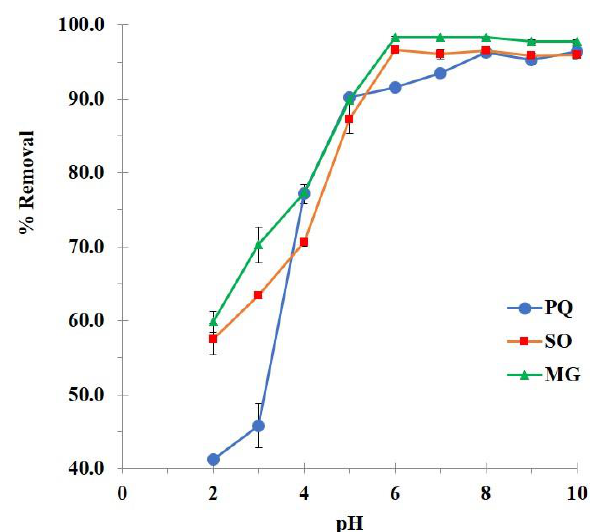
Figure 7. Influence of pH on the contaminant removal (conditions: 2 g/L of adsorbent dosage, 25 mg/L of initial concentration, 180 minutes of contact time, and temperature at 303 K).